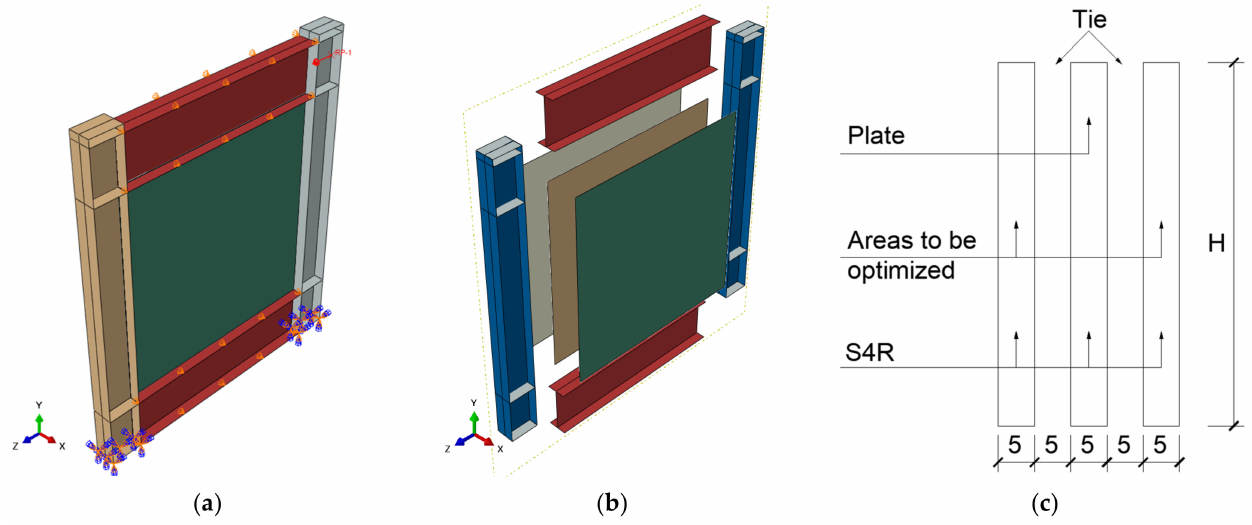
Figure 6. Finite element optimization model of SPSW. ( a ) Integral model of SPSW. ( b ) Explosion diagram of SPSW model. ( c ) Sandwich plate